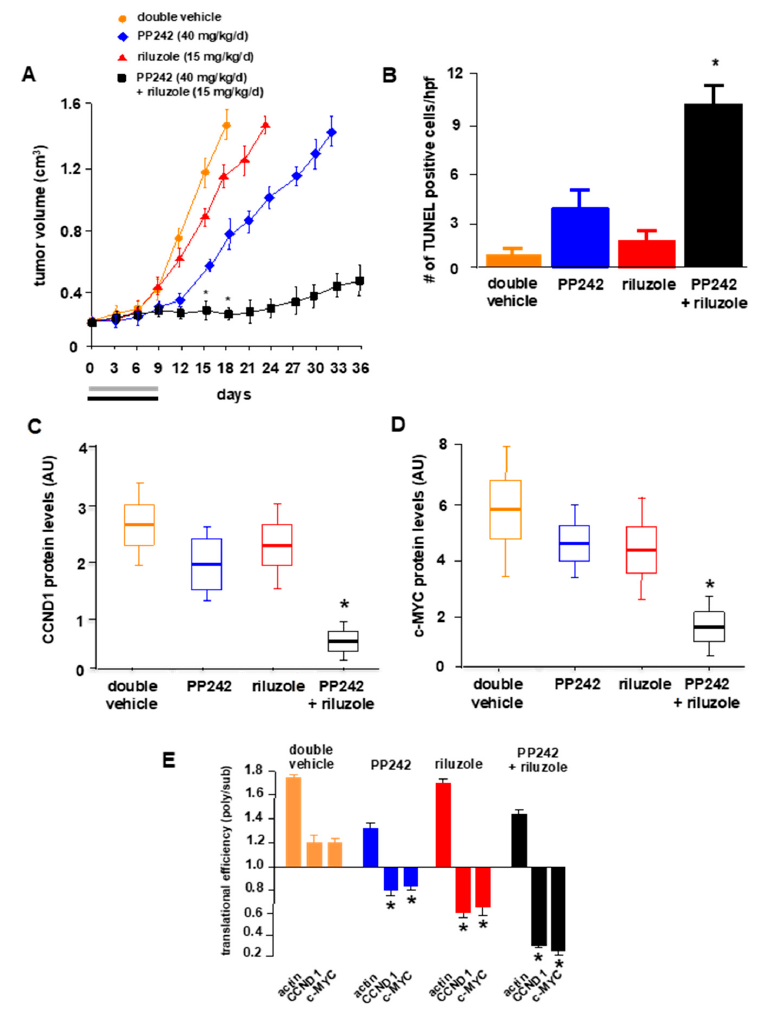
Figure 6. In vivo effects of riluzole and PP242 co-therapy. ( A ) Tumor volume of subcutaneous LN229 cell xenografts in mice treated with the indicated schedules of double vehicle, PP242 (grey bar), riluzole (black bar) or PP242 + riluzole for nine consecutive days and tumor growth monitored every 3 days following the start of treatment on day 0. * p < 0.05, significantly different from double vehicle, n = 6 mice per treatment group. ( B ) Sections prepared from harvested tumors at day 15 following the initiation of treatment schedules were subjected to TUNEL staining to determine apoptotic cell numbers. Data are expressed as the number of positive apoptotic bodies divided by high power field (hpf; 10–12 hpf/tumor). Values are means +S.D., * p < 0.05. ( C ) Box plots showing cyclin D1 protein levels in harvested tumors from mice treated with the indicated regimens. * p < 0.05. ( D ) As in ( C ), but values for c-MYC protein levels are shown. ( E ) Histogram showing translational efficiency of cyclin D1, c-myc or actin mRNAs determined by qrt-PCR as the ratio between polysomal and non-polysomal/monosomal RNA fractions at day 15. qrt-PCR measurements were performed in quadruplicate and the mean and + S.D. are shown. (* p < 0.05, significantly di ff erent from CCND1